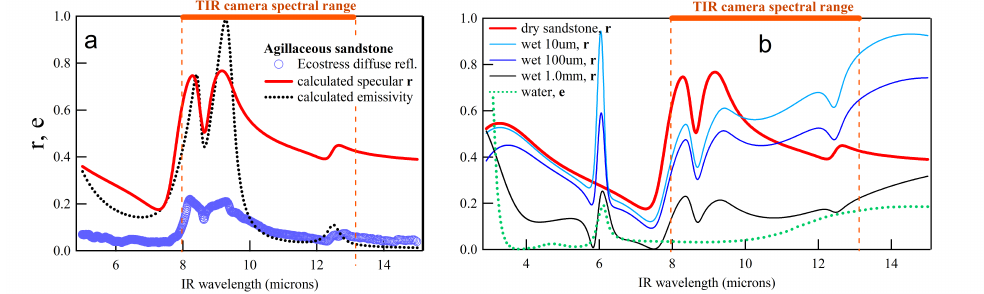
Figure 3. ( a ) Blue circles: diffuse reflectance data (spectral signature) of the argillaceous sandstone (sample No. Ward63 from the ECOSTRESS Spectral Library); calculated specular reflectance (red curve) and emittance (black dotted curve) of the same argillaceous sandstone sample. The Lorentz oscillator model has been used to fit the data and to perform the calculations. ( b ) calculated reflectance of dry argillaceous sandstone (red curve, same as left panel), with 10, 100 µ m of water on top of the rock surface (light, dark cyan line) and with 1 mm of water on top (black line). The green dotted line is the emittance of liquid water (green